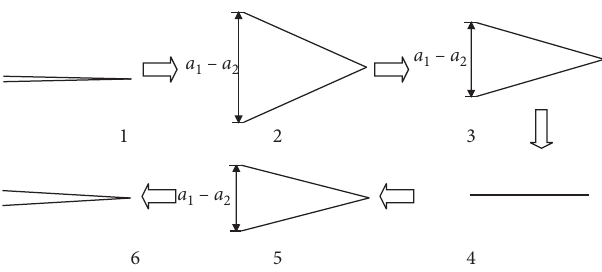
Figure 5: Schematic showing the crack-tip opening displacement in stage-wise fashion for cracks I and